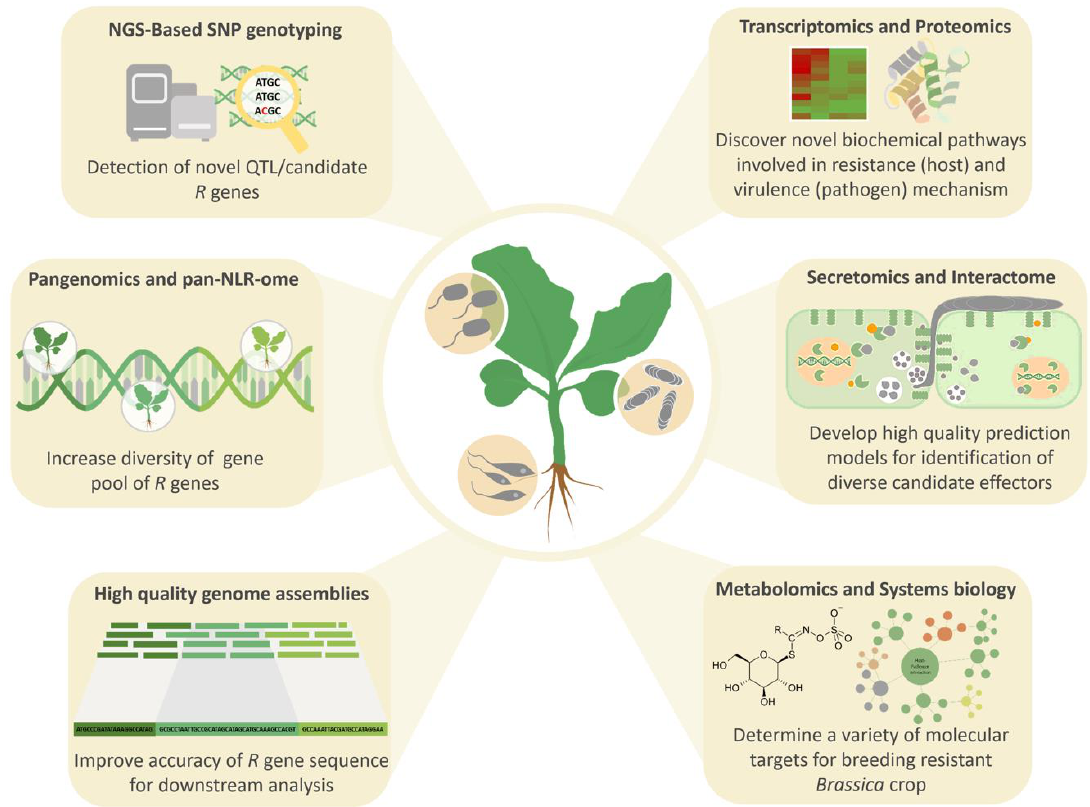
Figure 2. The application of multi-omics technologies in the discovery of novel plant–pathogen interactions in the Brassica pathosystems.